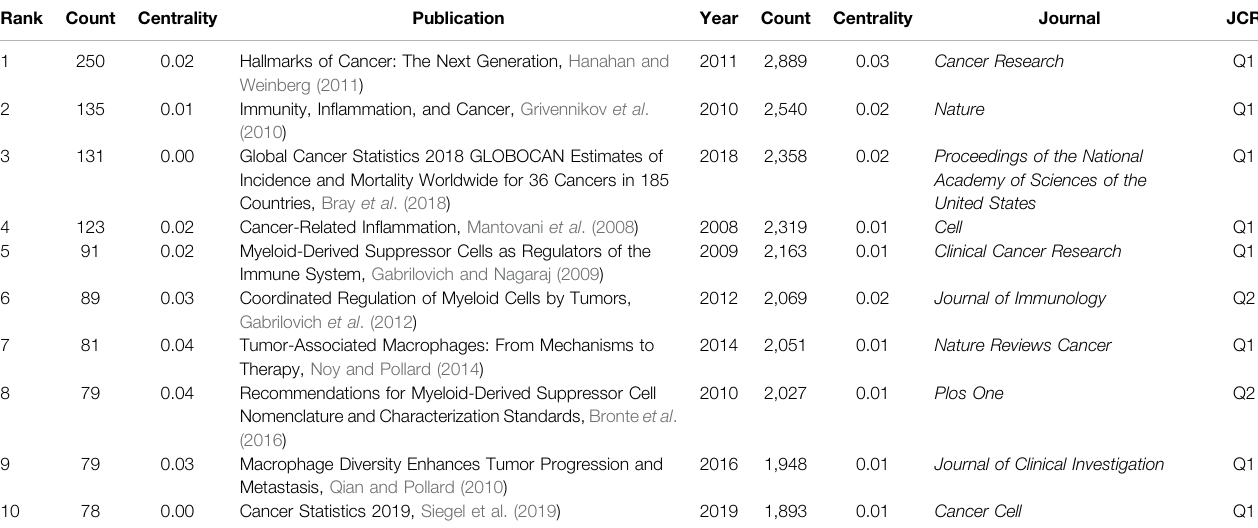
TABLE 2 | Top 10 co-cited publications and journals on in fl ammatory tumor microenvironment. Rank Count